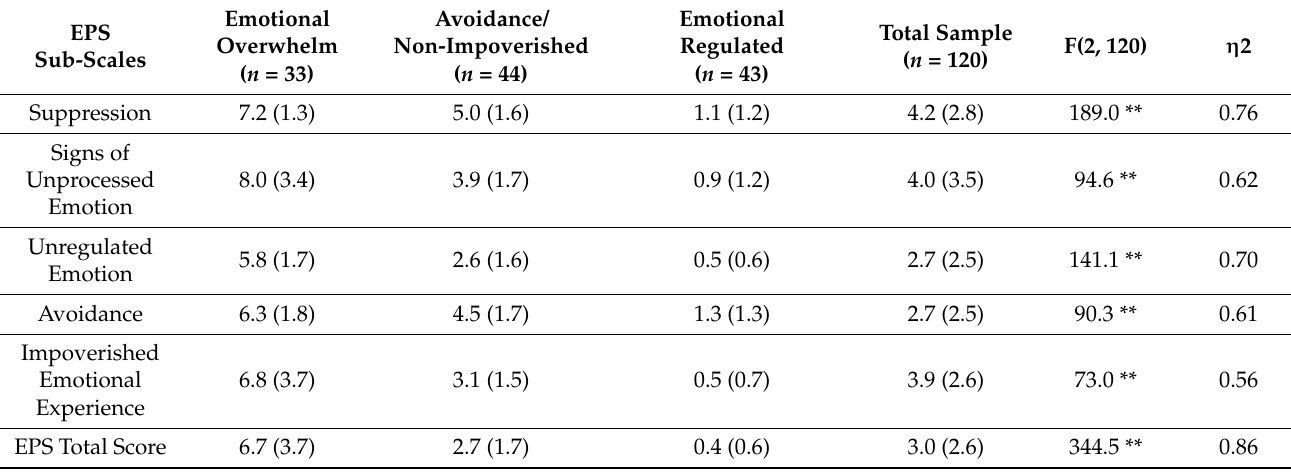
Table 1. Distribution of the three subtypes on the Emotional Processing Scale (EPS) sub-scales included in the two-step cluster